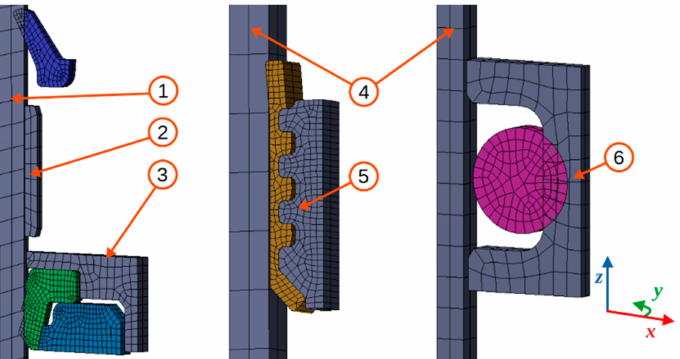
Figure 4. Geometry abstraction and mesh (undeformed) for the FEM simulation; left: 4 ◦ wedge of the rod guide assembly/rod friction point; center: 4 ◦ wedge of the piston/tube friction point; right: 4 ◦ wedge of the floating piston/tube friction